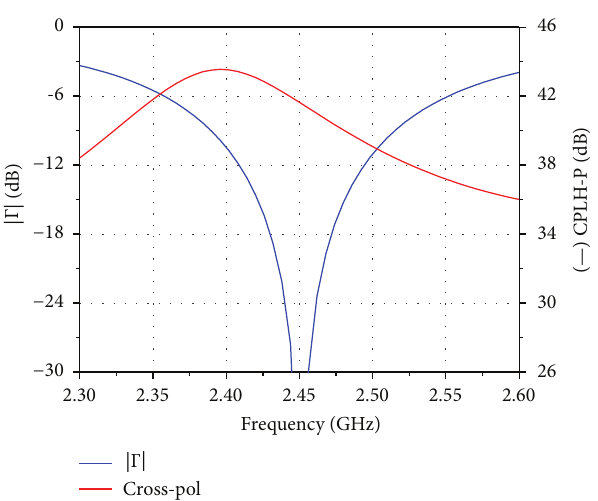
Figure 7: Reflection coefficient magnitude and CPLH-P of the CBHM antenna.